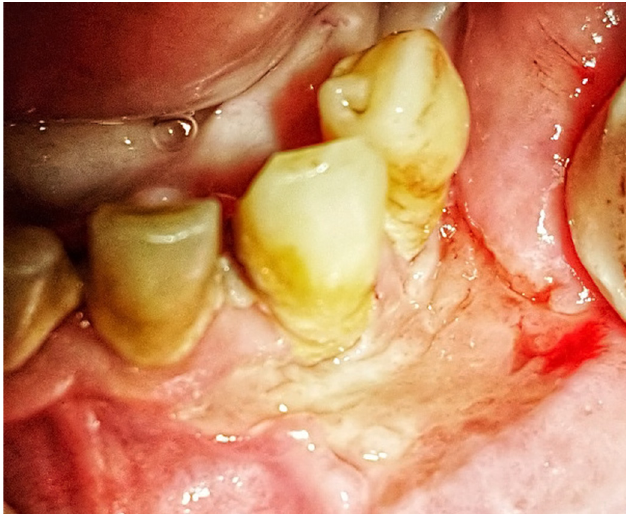
Fig. 1. Intraoral view of the gingival ulcer.